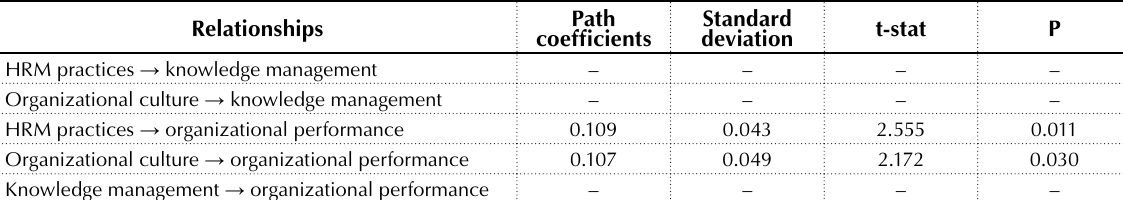
Table 4. The results of indirect effects